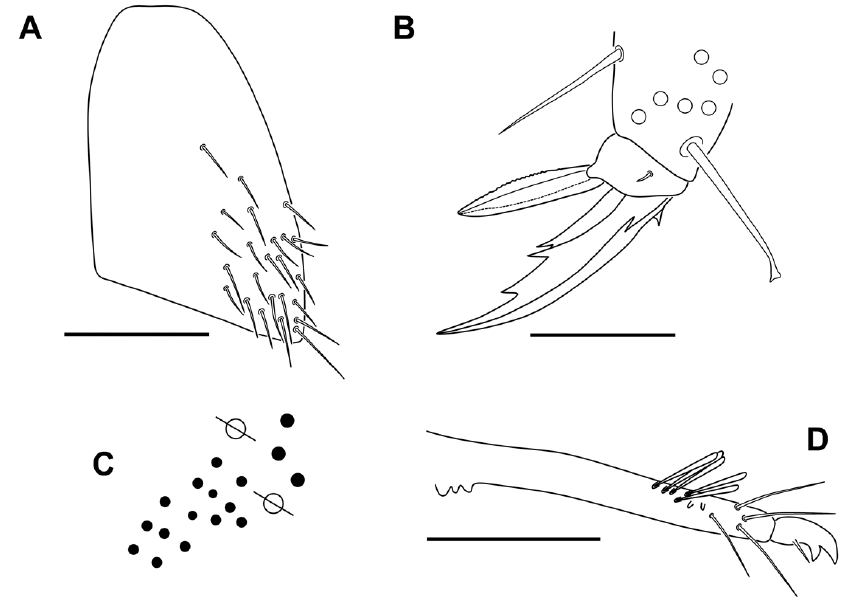
Figure 11. Pseudosinella impariciliata Baquero and Jordana sp. nov.: ( A ) trochanteral organ; ( B ) claw of leg III; ( C ) pseudopores and chaetae of manubrial plate; ( D ) distal area of dentes and mucro (scale bar, 0.05 mm).